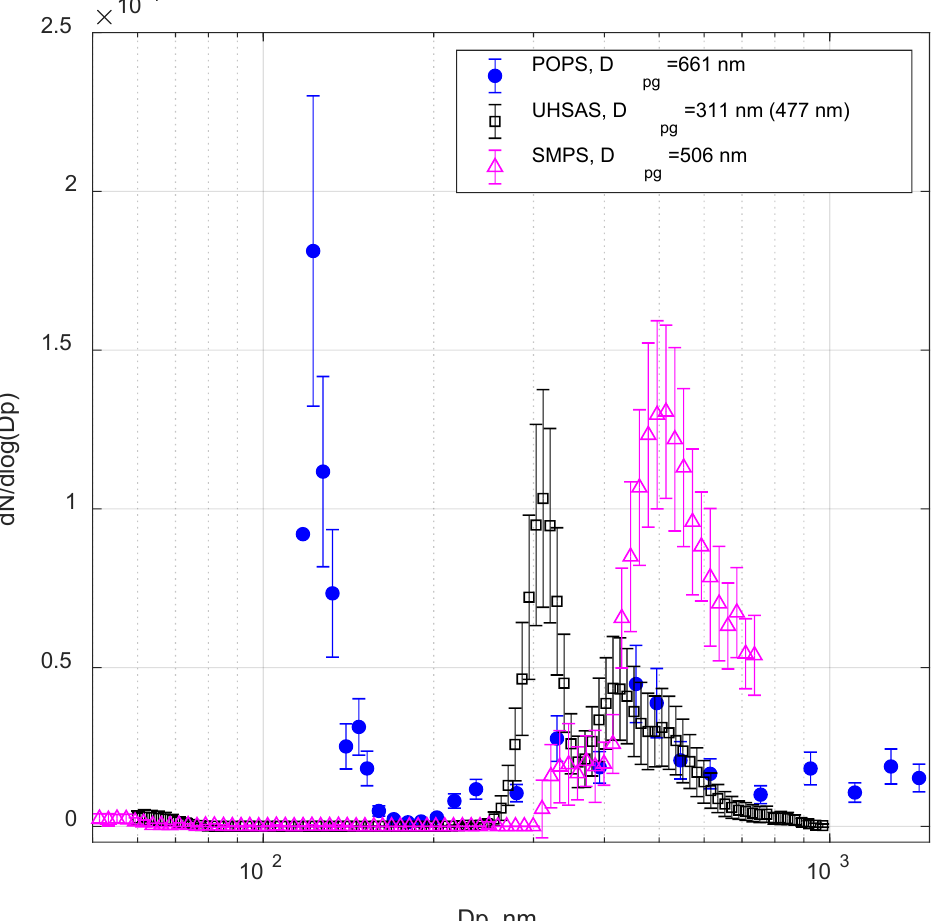
Figure 7. POPS and Passive Cavity Aerosol Spectrometer (PCASP) size distribution of 500 nm (electrical mobility size) titanium dioxide particles.